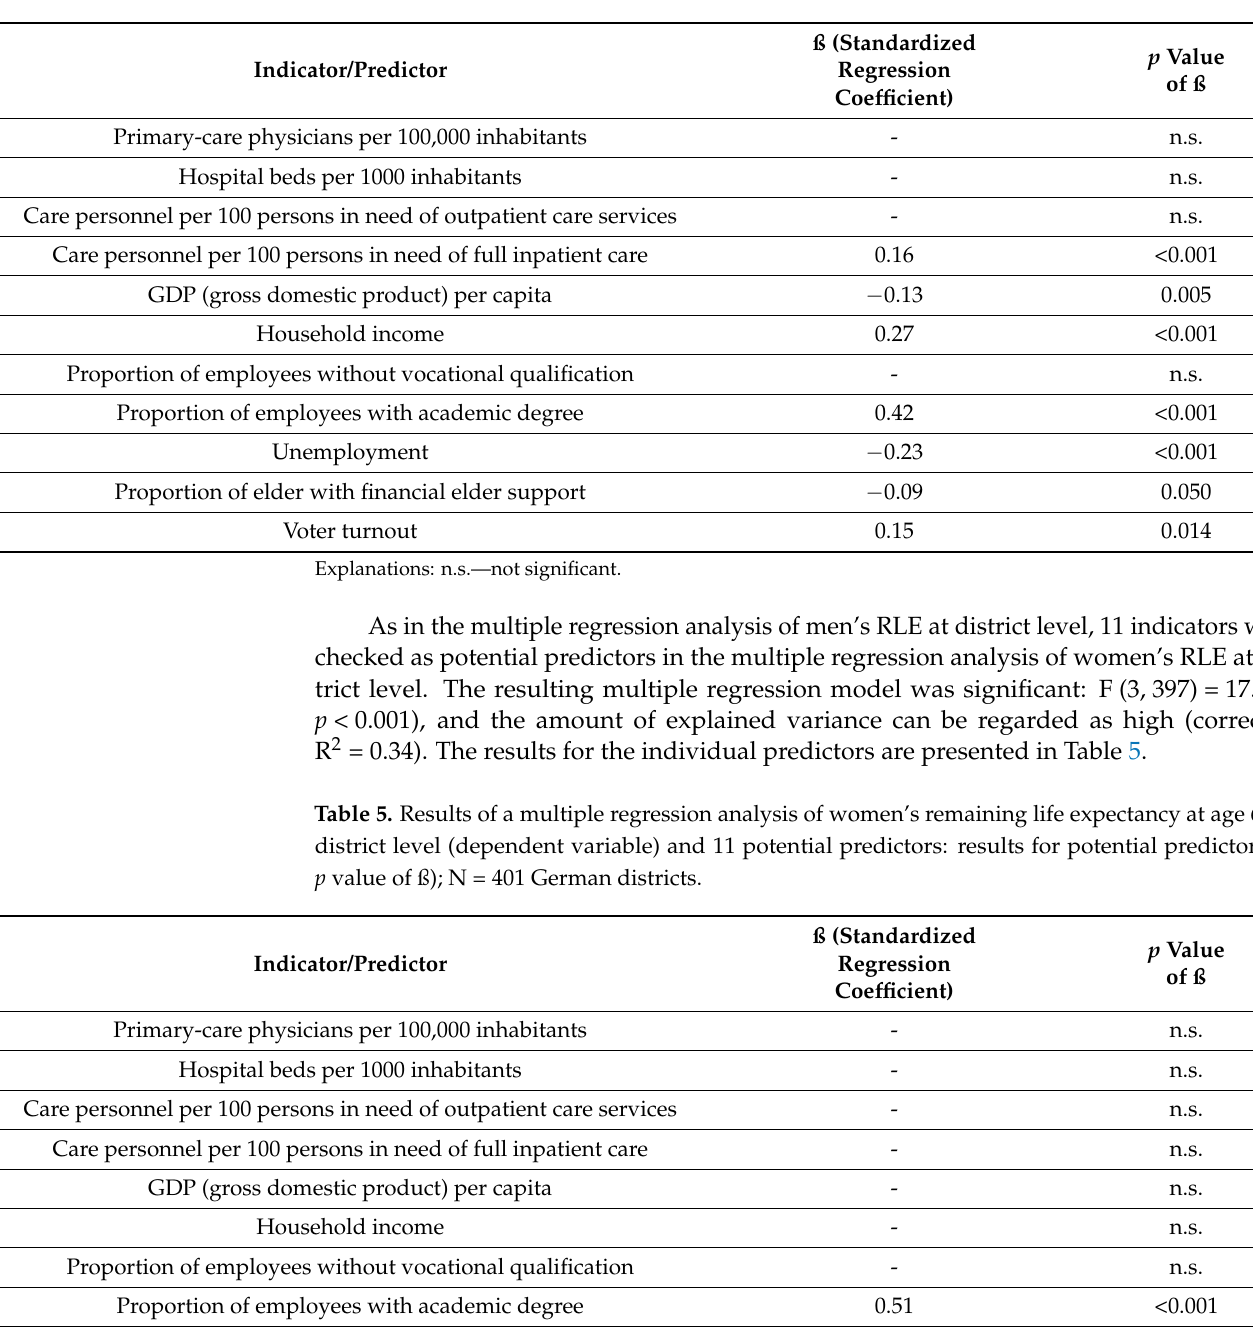
Table 4. Results of a multiple regression analysis of men’s remaining life expectancy at age 60 at district level (dependent variable) and 11 potential predictors: results for potential predictors (ß; p value of ß); N = 401 German districts.